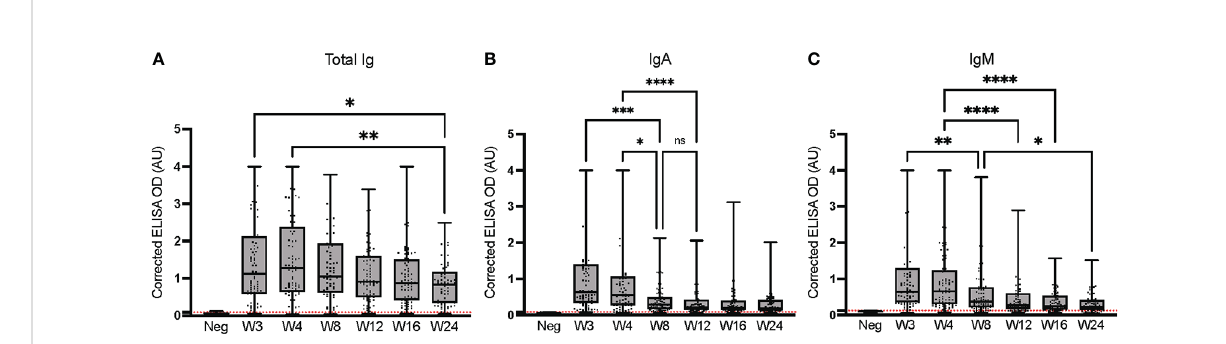
FIGURE 3 Longitudinal assessment of anti-spike (Wuhan-Hu-1 strain) immunoglobulins at the HQ site. ELISAs were conducted at the HQ site using serum samples from 79 PCR-con fi rmed SARS-CoV-2-positive individuals. (A) Total Ig; (B) IgA; (C) IgM. The post-vaccination samples of the nine individuals who were vaccinated during the study were excluded. The secondary antibodies are listed in Table 2. The average of triplicate assays is given as a corrected OD. The average of triplicate assays is given as corrected OD. The median is shown in the quartile boxplots where the whiskers include all values (no outliers excluded). Negative controls using serum from eight SARS-CoV-2-negative individuals are given as the average of triplicate assays. ns: not signi fi cant; *p < 0.05; **p < 0.01; ***p < 0.001; ****p < 0.0001. Neg: Negative controls. Positivity threshold (red dashed line) for total Ig: 0.091; IgA: 0.083; IgM: 0.123. Results for the seroconversion ROC analyses for these datasets are presented in Supplementary Table